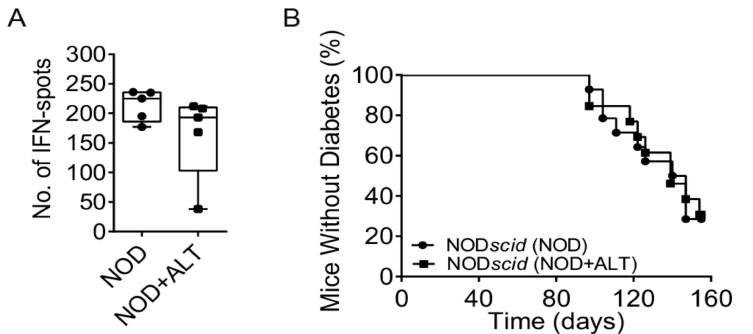
Figure 3. Systemic immune cells retain their function following short-term AGE lowering therapy with alagebrium chloride (ALT). ( A ) NOD ShiLt control mice (NOD, • ) and NOD ShiLt treated with alagebrium (NOD + ALT, 1 mg/kg/day, s.c; (cid:4) ) were immunised with OVA/QuilA and 1 week later spleens harvested and the number of cells producing IFN- γ in responses to OVA restimulation enumerated with ELISpot. ( n = 3 replicates from n = 5 mice/group, n = 2 independent experiments). ( B ) Diabetes incidence after adoptive transfer of control or ALT treated (for ~30 days) diabetogenic NOD ShiLt splenocytes into NOD scid recipients aged 6–7 weeks old. N = 13–14/recipient group (1 × 10 6 –2 × 10 7 cells/mouse). (cid:4) NOD + ALT into NOD scid recipients; • NOD into NOD scid